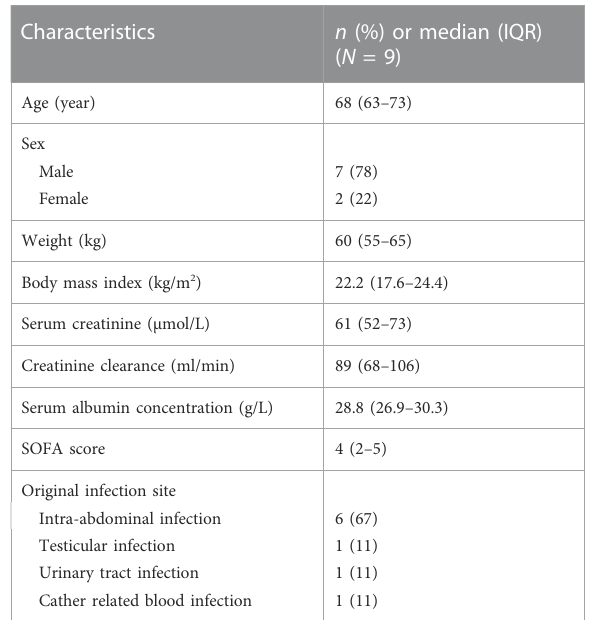
Cather related blood infection 1 (11) IQR, interquartile range; SOFA, sequential organ failure assessment.